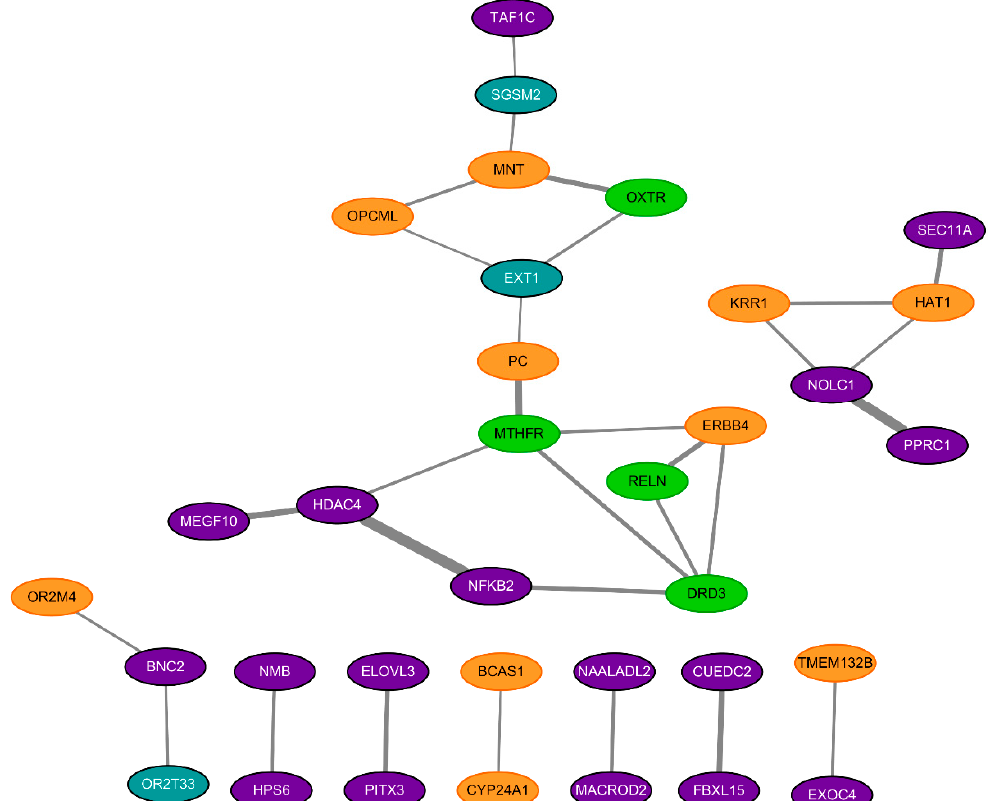
Figure 2. Protein-protein interaction network of ASD. There were 34 distinct genes with about 30 genetic connections among them. The thickness of the line connecting genes represents the score of PPI interaction using STRING9.1 and the color of each gene represents the source of the data; orange, GWAS data: green, GWAS catalog: purple, meta-analysis of GWAS: light green, meta-analysis of observational studies.